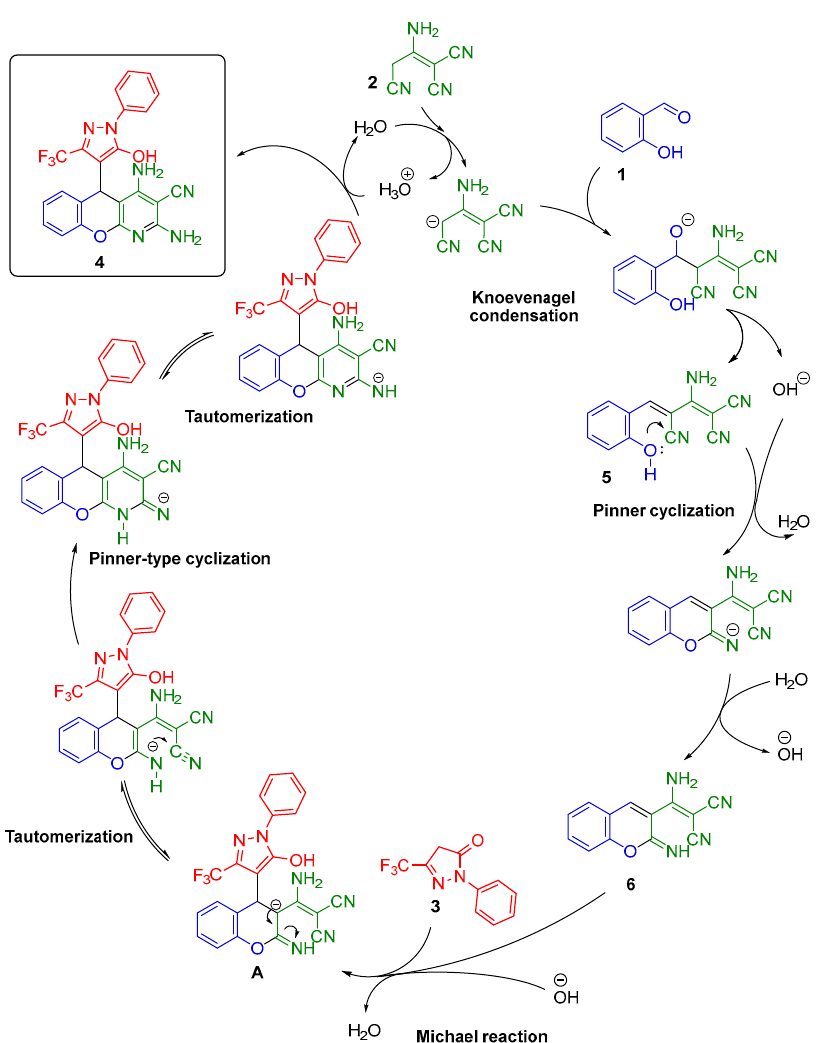
Figure 4. The ‘BOILED-Egg’ diagram for chromeno[2,3- b ]pyridine ( 4 ). Some of the calculated ADME parameters are presented in Table 1. It also follows from the calculations that compound 4 complies with the Lipinski [25], Ghose [26], Veber [27], and Muegge [28] rules. Table 1. Calculated ADME parameters of synthesized chromeno[2,3- b ]pyridine ( 4 ). Parameter